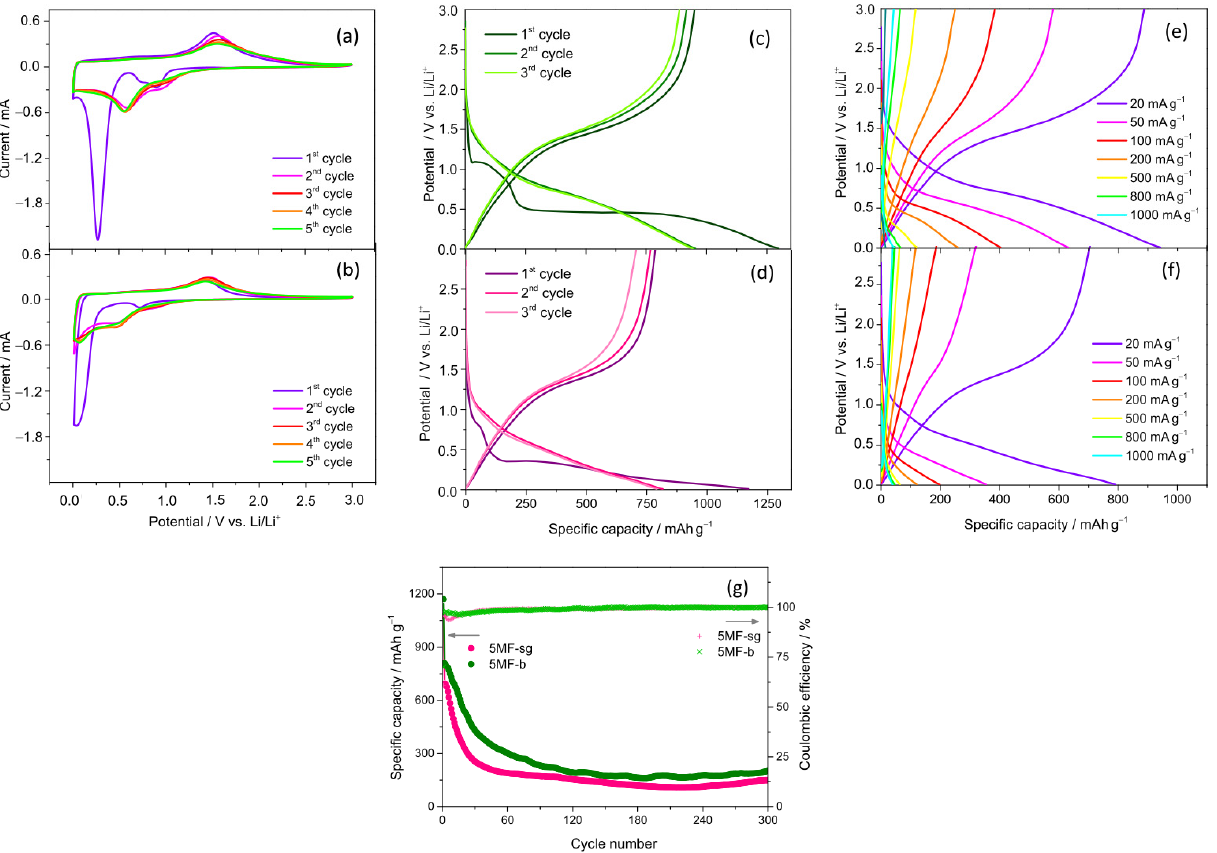
Figure 5. Electrochemical performance of HESOs ( a , c , e ) 5MF-b and ( b , d , f ) 5MF-sg in Li-ion half cells. ( a , b ) CV curves (scanning rate of 0.1 mV s − 1 ), ( c , d ) galvanostatic charge–discharge curves measured at 20 mA g − 1 and ( e , f ) galvanostatic charge–discharge curves measured at different current density. ( g ) Cycling stability at a current density of 500 mA g − 1 .